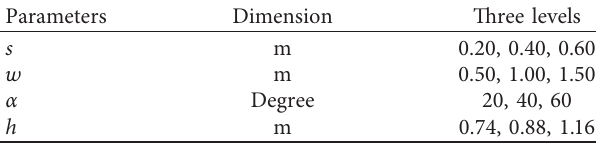
Table 1: Three levels of parameters.